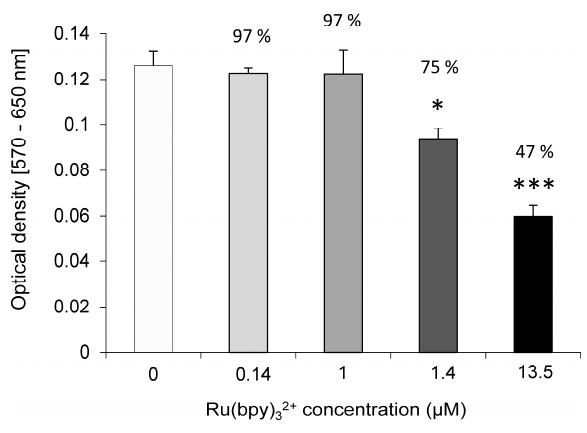
Figure 7. MTT assay plot of HDF cells vitality: Controls (0) and exposed samples to 0.14; 1; 1.4; 13.5 μM of Ru(bpy) 32+ . Significance of data is reported (*).